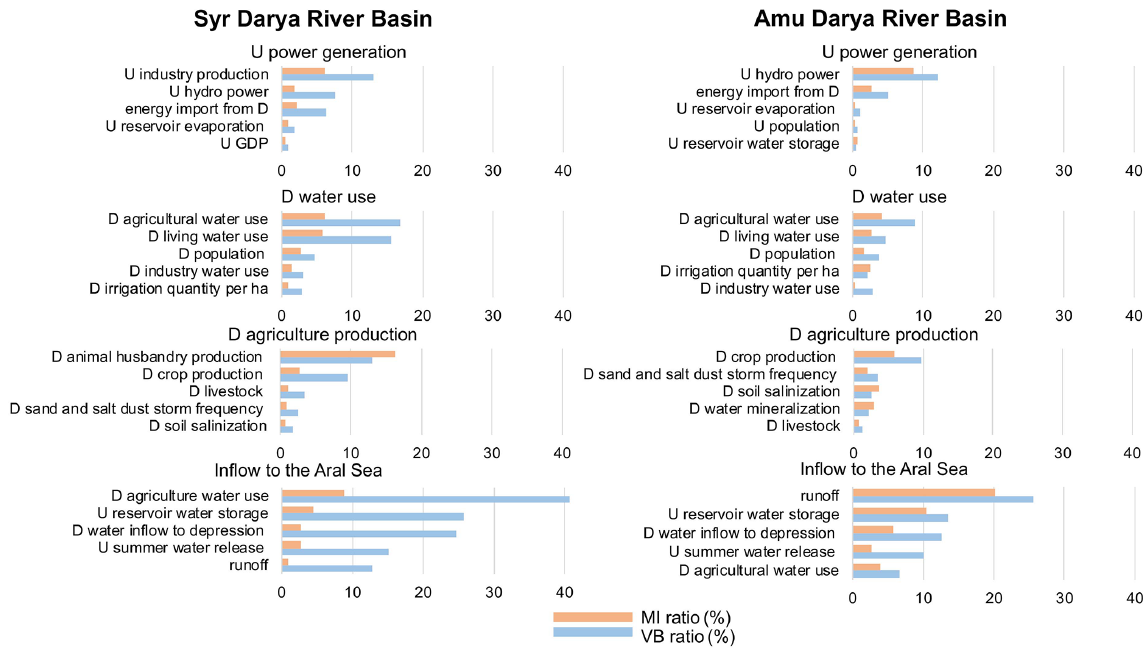
Figure 7. Sensitivity analysis of some variables. VB stands for “variance of belief” and MI stands for “mutual information”. D stands for “downstream”; correspondingly, U stands for